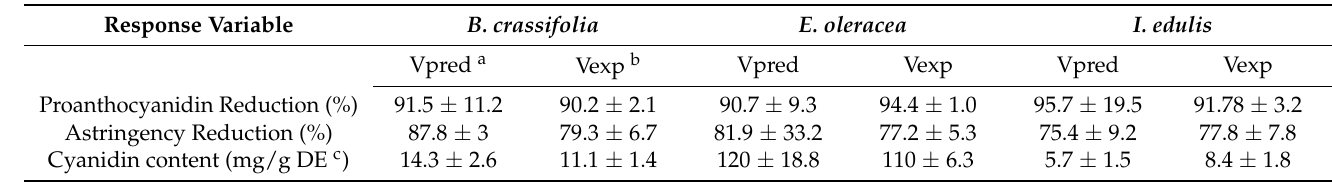
Table 5. Predicted and experimental results for the response surface methodology under the optimal